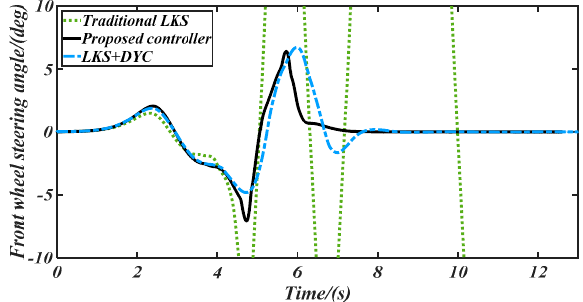
Figure 15. The front steering angle controlled by different controllers.